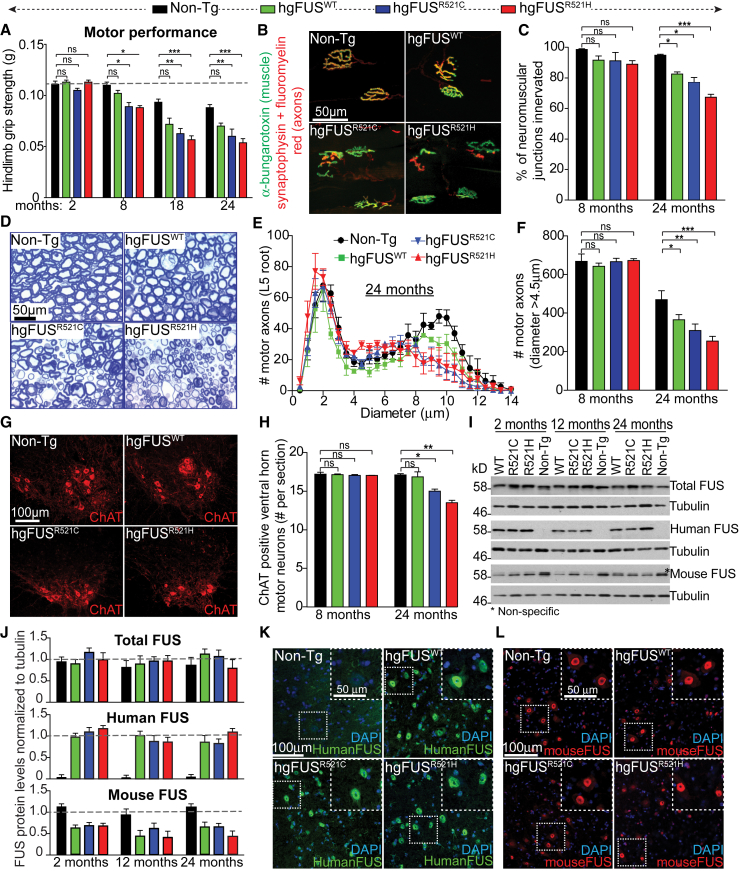
ALS-Linked FUS Mutants Show Age-Dependent Progressive Motor Impairments without Nuclear Mislocalization or Aggregation of FUS(A) Hindlimb grip strength measured up to 24 months. Data are represented as mean ± SEM (n ≥ 12 per group). ∗p < 0.05, ∗∗p < 0.01, ∗∗∗p < 0.001, ns: non-significant using one-way ANOVA.(B) Gastrocnemius muscle sections from 24-month-old Non-Tg, hgFUSWT, hgFUSR521C, and hgFUSR521H mice with axons immunostained using a synaptophysin antibody and FluoroMyelin™ red (red) and muscle endplates using α-bungarotoxin (green). Scale bar, 50 μm.(C) NMJ innervation of the gastrocnemius from 8- and 24-month-old Non-Tg, hgFUSWT, hgFUSR521C, and hgFUSR521H mice. Data are represented as mean ± SEM (n ≥ 3 mice per group). ∗p < 0.05, ∗∗∗p < 0.001, two-sided unpaired Student’s t test.(D) Lumbar motor axons from 24-month-old Non-Tg, hgFUSWT, hgFUSR521C, and hgFUSR521H mice. Scale bar, 50 μm.(E) Size distribution per motor axon in the L5 motor root of 24-month-old Non-Tg, hgFUSWT, hgFUSR521C, and hgFUSR521H mice. Data are represented as mean ± SEM (n ≥ 3 per group). ∗p < 0.05, ∗∗p < 0.01 and ∗∗∗p < 0.001, two-sided unpaired Student’s t test.(F) Total number of α-motor axons (caliber size > 4.5 μm) in the L5 motor root of 8- and 24-month-old Non-Tg, hgFUSWT, hgFUSR521C, and hgFUSR521H mice. Data are represented as mean ± SEM (n ≥ 3 per group).(G) Lumbar spinal cord sections from 24-month-old Non-Tg, hgFUSWT, hgFUSR521C, and hgFUSR521H mice immunostained using a ChAT antibody to reveal cholinergic motor neurons. Scale bar, 100 μm.(H) Total number of ChAT-positive motor neurons in lumbar spinal cords of 8- and 24-month-old Non-Tg, hgFUSWT, hgFUSR521C, and hgFUSR521H mice. Data are represented as mean ± SEM (n ≥ 3 per group). ∗p < 0.05, ∗∗p < 0.01, two-sided unpaired Student’s t test.(I) Total human and/or mouse FUS protein levels in spinal cords of 2-, 12-, and 24-month-old hgFUSWT, hgFUSR521C, hgFUSR521H, and Non-Tg mice. Tubulin was used as a loading control. Asterisk illustrates a non-specific band recognized by the antibody against mouse FUS.(J) Quantification of immunoblots shown in (I). Data are represented as mean ± SEM from two independent experiments.(K and L) Lumbar spinal cord sections from 24-month-old Non-Tg, hgFUSWT, hgFUSR521C, and hgFUSR521H mice immunostained using an antibody recognizing specifically (K) human or (L) mouse FUS. DNA is stained with DAPI. Scale bars, 100 μm and 50 μm (inset). See also Figure S2.